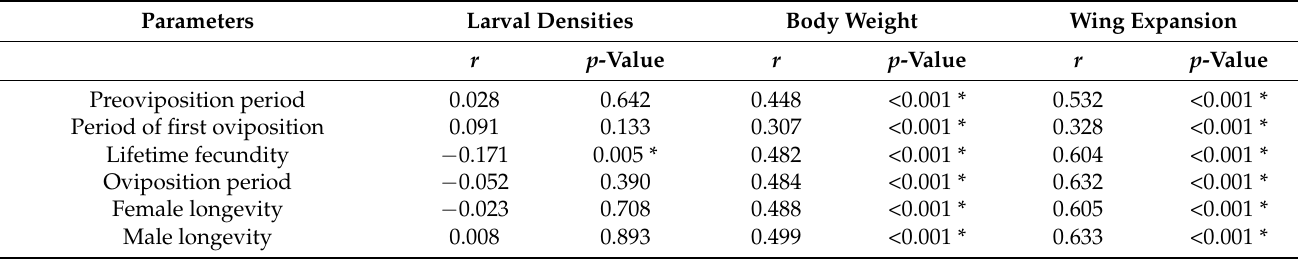
Table 1. Pearson correlations of reproduction of Spodoptera frugiperda under different larval densities, with body weight and wing expansion.